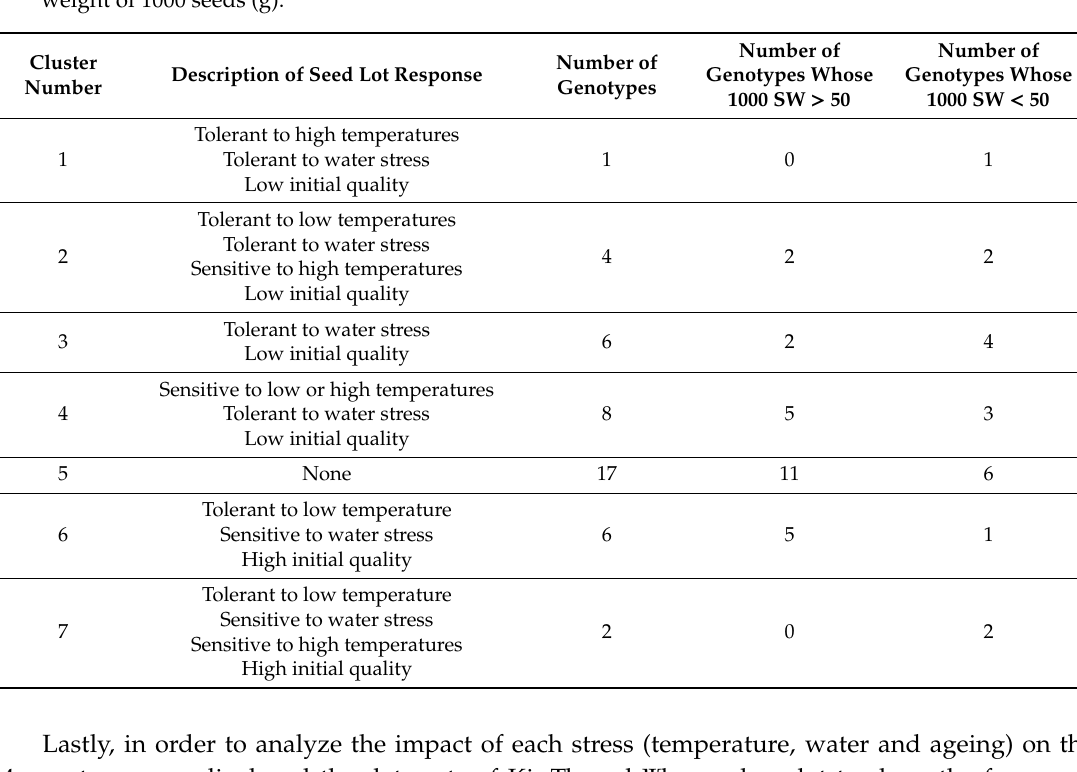
Table 3. Description of genotypes belonging to the different clusters; 1000 SW corresponds to the weight of 1000 seeds (g).